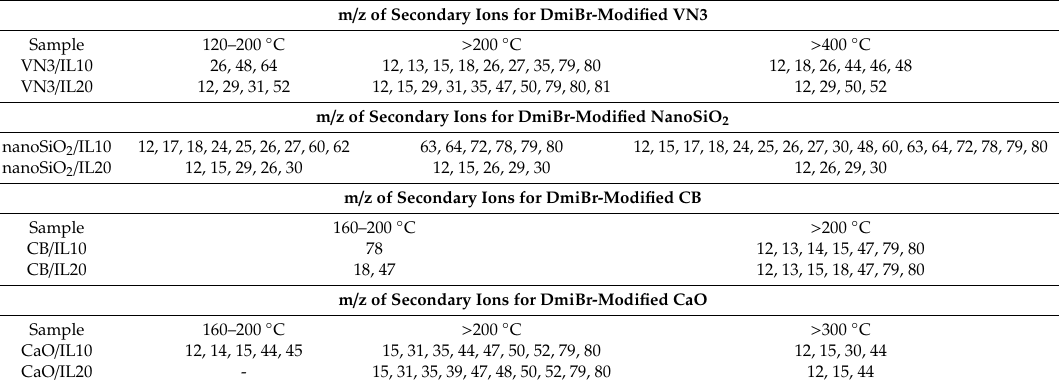
Table 4. MS analysis for DmiBr-modified